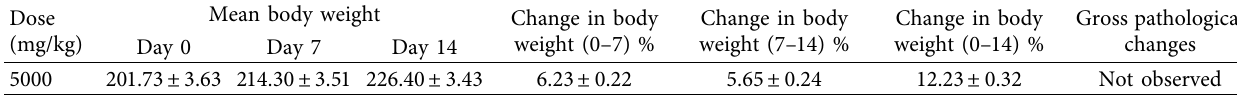
Table 1: Effect of GutGard on body weight and gross pathology during 14-day (acute) oral toxicity.